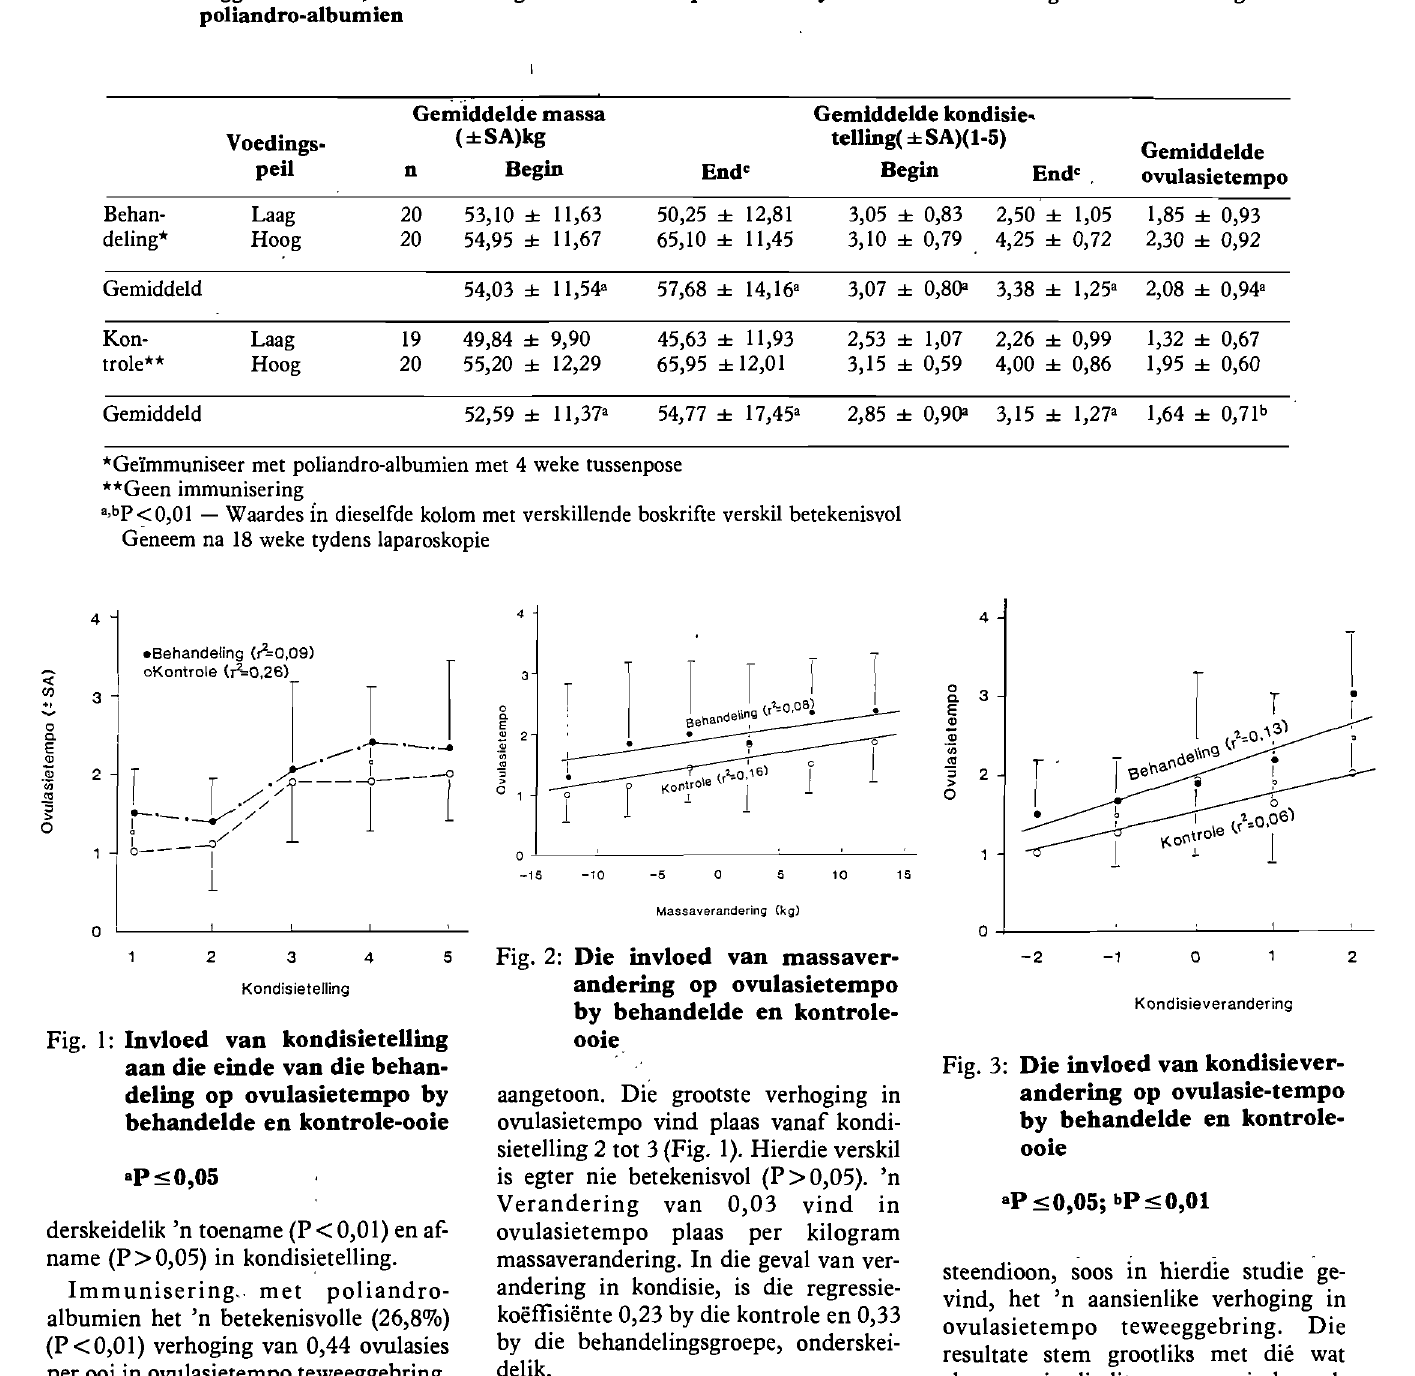
Tabel I: Liggaamsmassa, kondisietelling en ovulasietempo in ooie by 2 vlakke van voeding en immunisering met poliandro-albumien